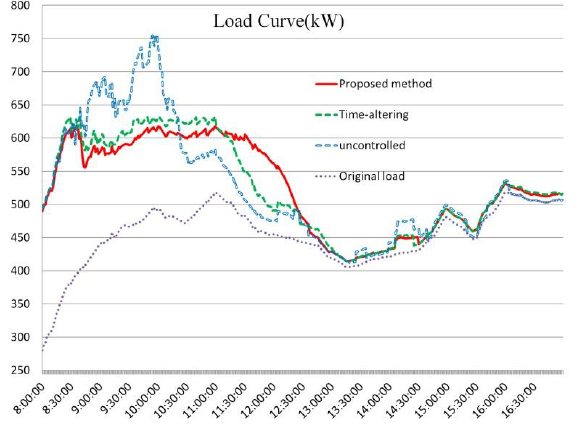
Figure 5. Load curve comparison of different charging control methods. Table 1. Peak and valley values and variance of load curves.